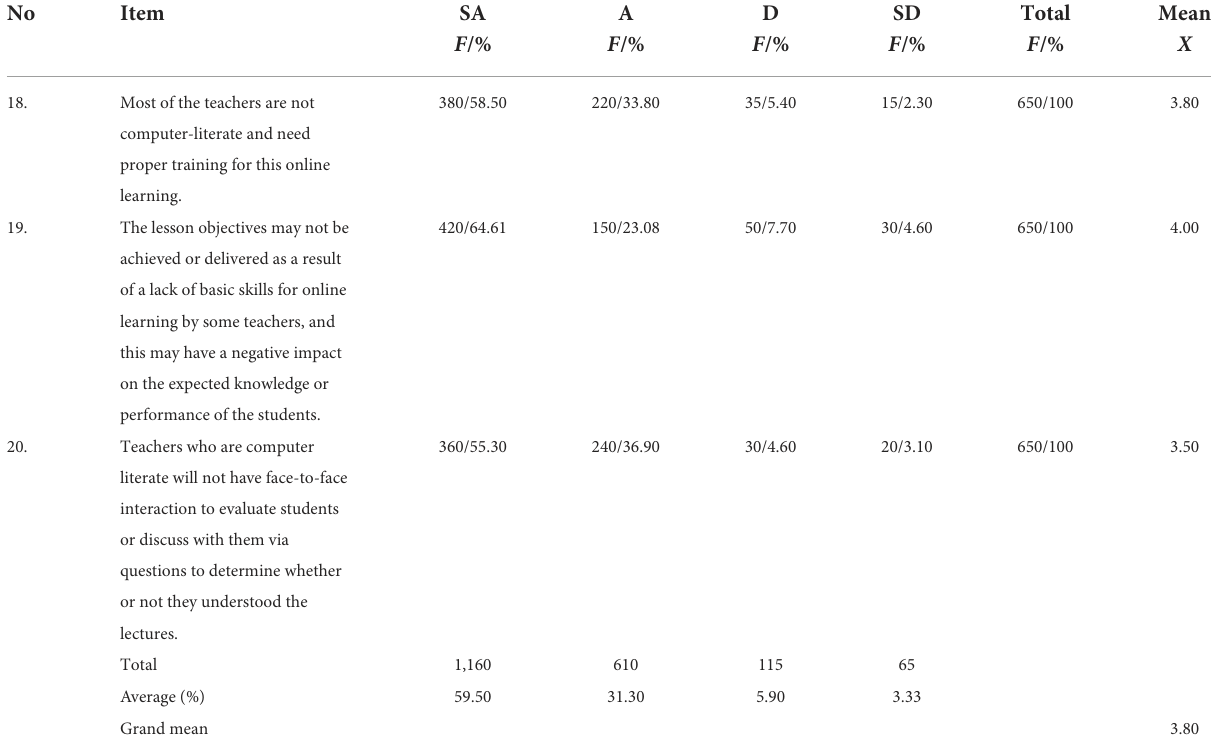
TABLE 5 Responses as to whether all the teachers have the basic skills for successful delivery of online